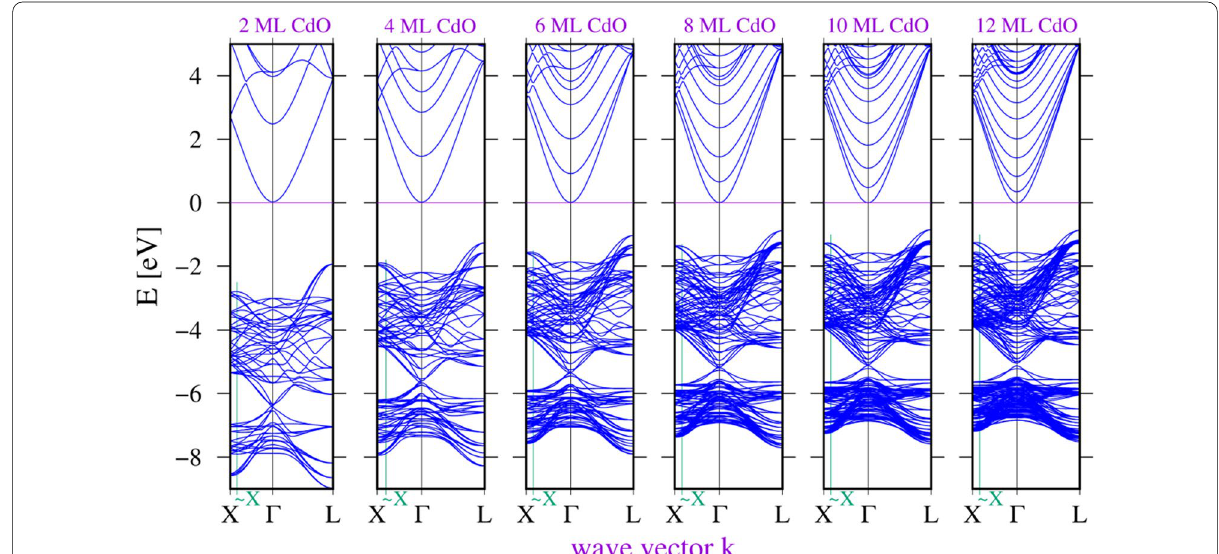
Fig. 6 Calculated band structures of cubic {CdO/MgO} SLs for various numbers of CdO monolayers and for four monolayers of MgO, using the GGA-1/2 method